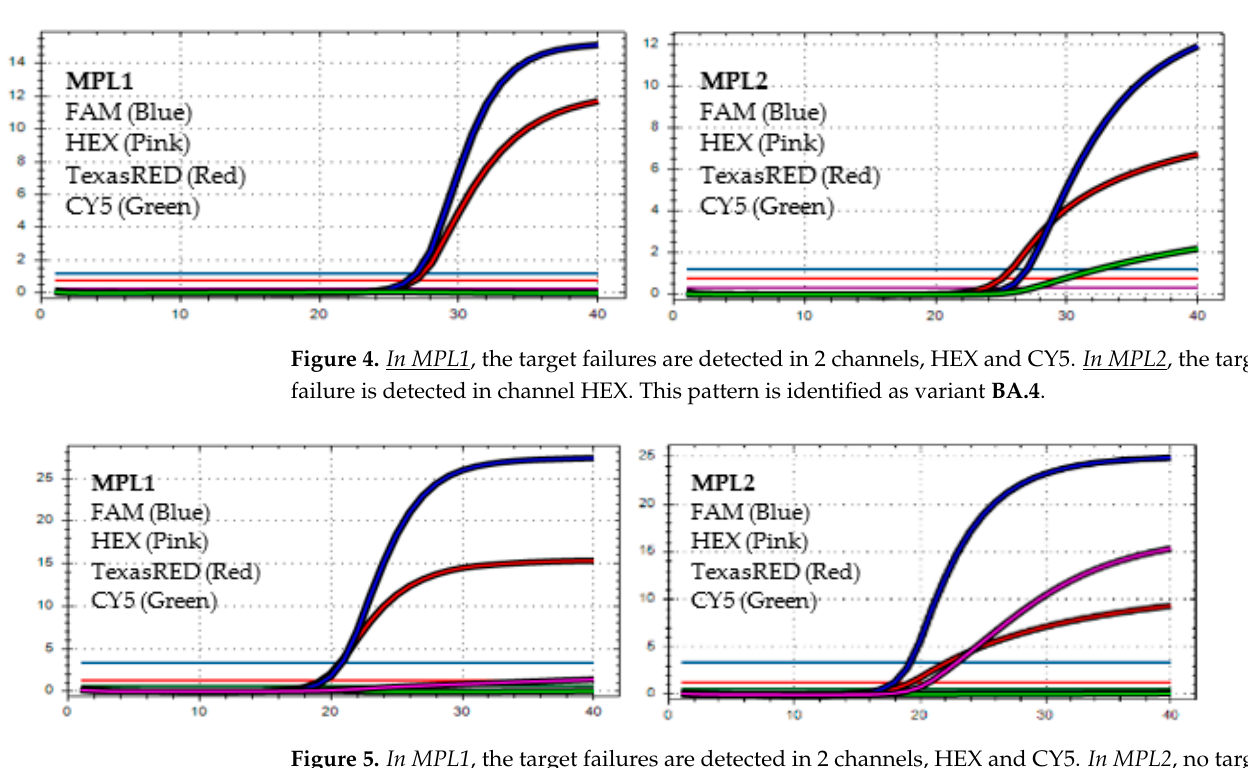
Figure 3. In MPL1 , the target failures are detected in 2 channels, TexasRED and CY5. In MPL2 , no target failure is detected in 3 channels, FAM, HEX, and TexasRED. No amplification is detected in channel CY5 because of the competition of high viral load with the IC (human RNAse P). This pattern is identified as the recombination of BA.1 and BA.2 (BA.1/BA.2) .